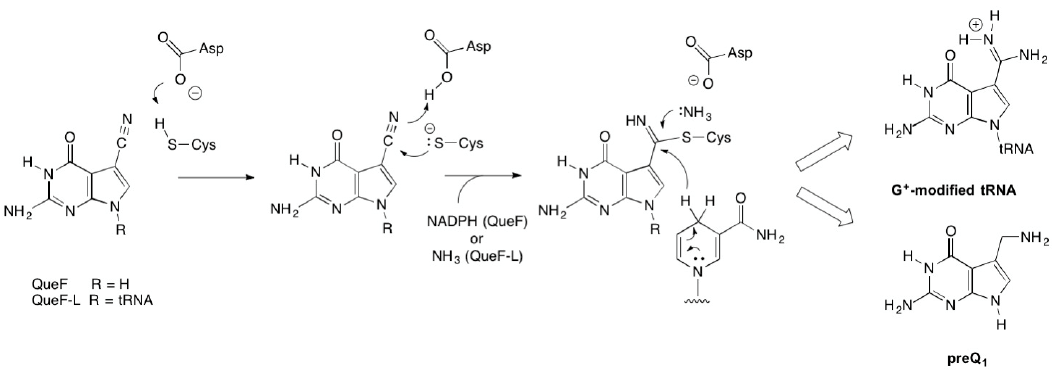
Figure 8. The common mechanistic steps leading to covalent thioimide intermediates in the reactions catalyzed by QueF and QueF ‐ L.